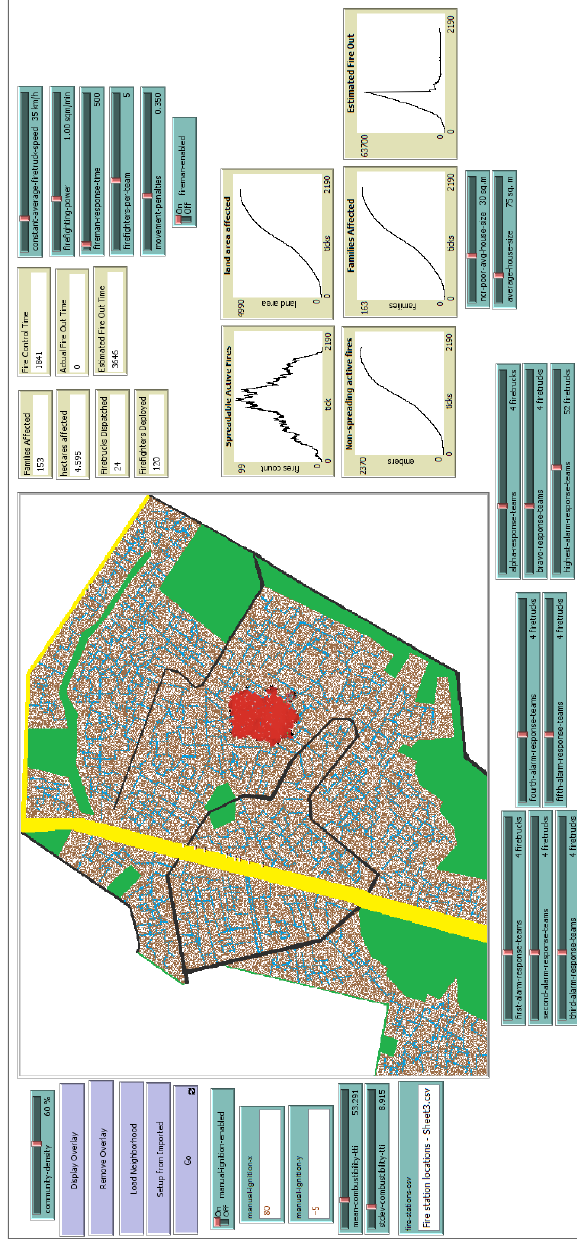
Figure 10 . A larger view of the whole experiment at 60% density, showcasing the graphs and variables used in the entirety of the